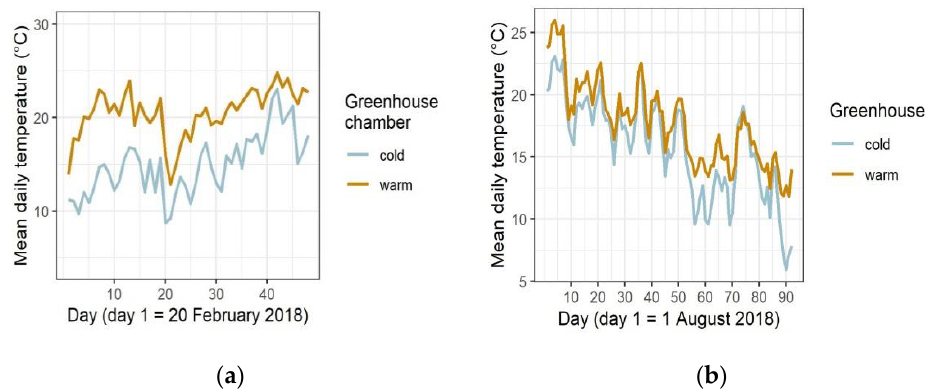
Figure 2. Mean daily greenhouse temperatures in spring ( a ) and in summer – autumn ( b ) in 2018.